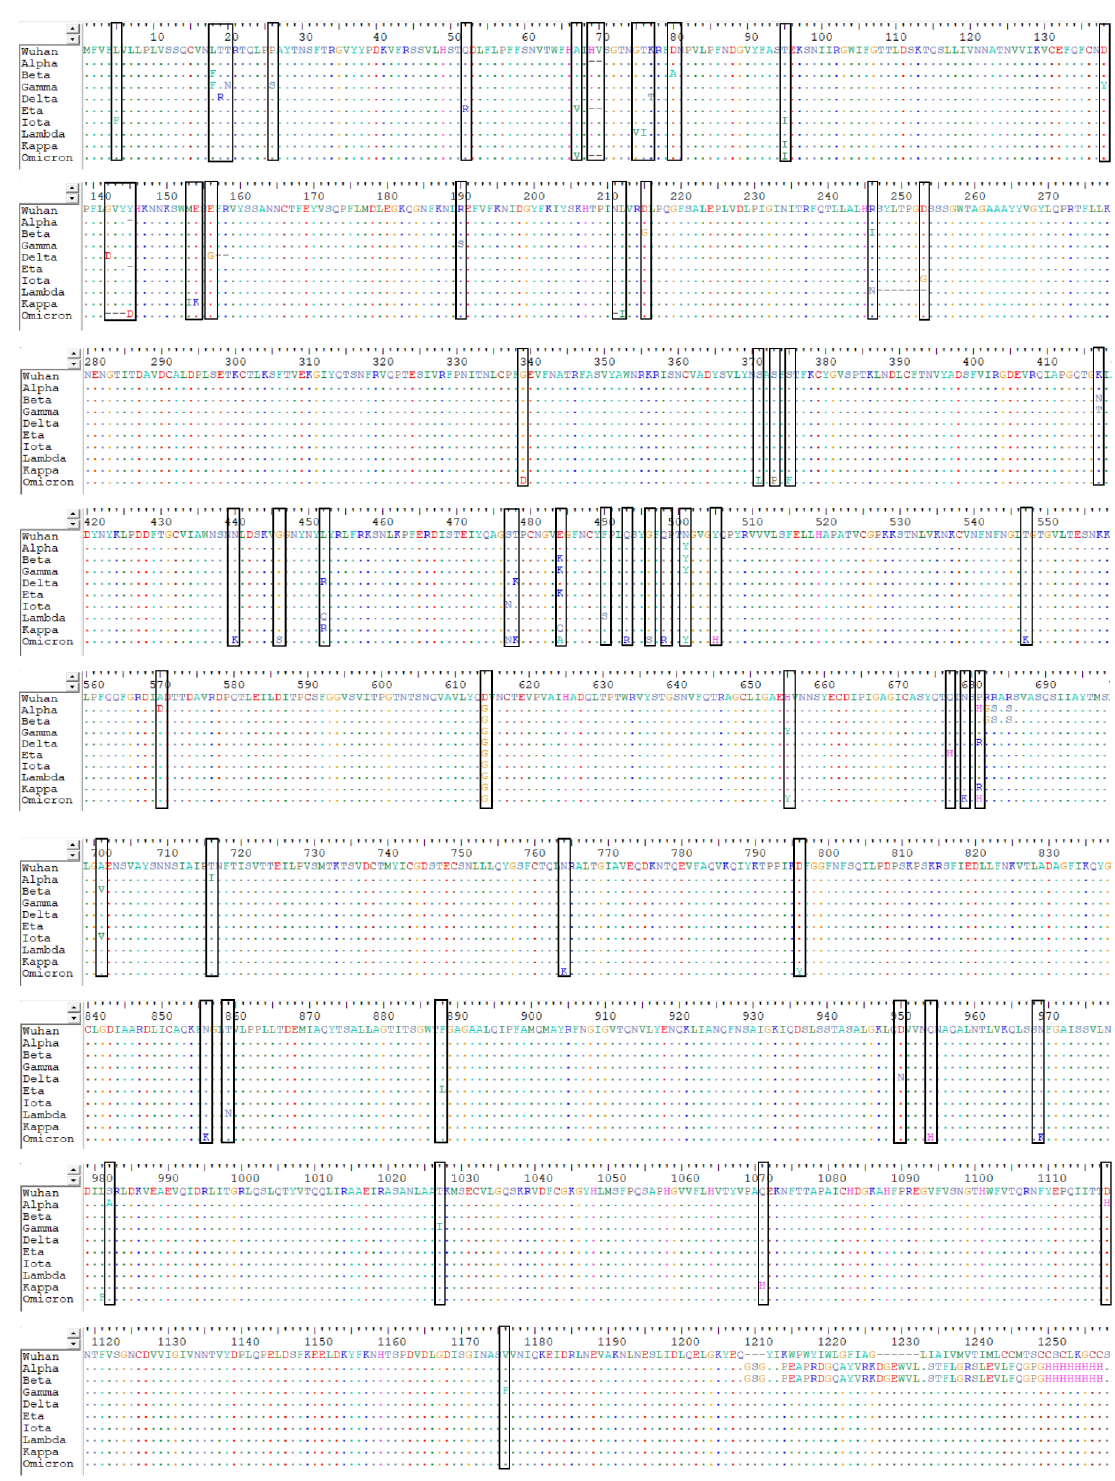
Figure 7. Alignment between sequences of spike glycoprotein of SARS-CoV-2 variants. Amino acid variations within each variant are marked at the particular positions. (In order from up to down; wild type (PDB ID: 6VYB), Alpha (PDB ID: 7LWT), Beta (PDB ID: 7LYQ), Gamma (accession no.: QQX12069.1), Delta (accession no.: QWO57033), Eta (accession no.: QWO17721.1), Iota (accession no.: QTP80309.1), Kappa (accession no.: QTY54081.1), Lambda (accession no.: QRX62290.1)) (alignment of sequences using